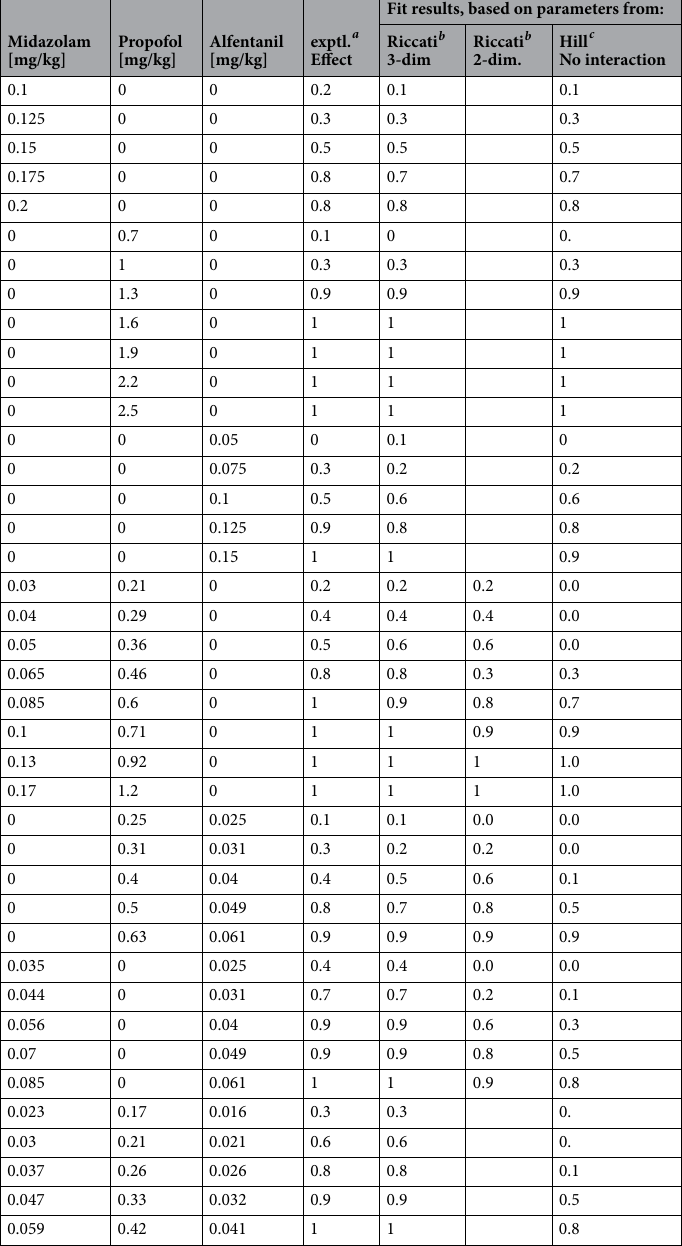
Table 2. Anesthetic mixtures: Exptl. data vs. ’full’- and ’null’-interaction models. a Data from 41 , 0 = no Table 1. c Hill’s equation for pure compounds, null-interaction model u Hill , Eq. (4),